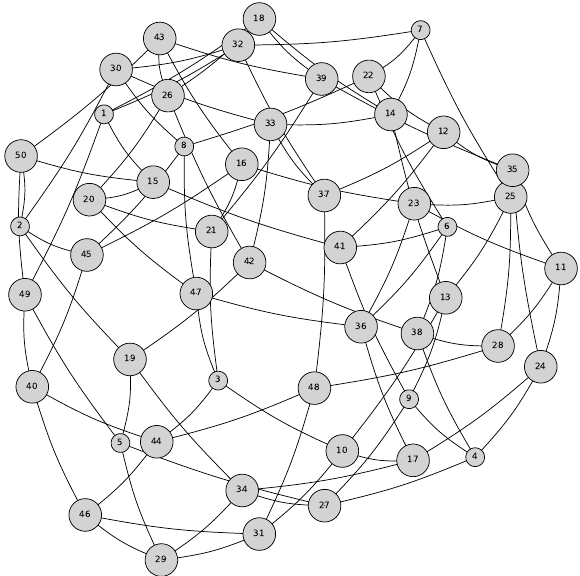
Figure 2. Unweighted random regular graph (N = 50, N cd =